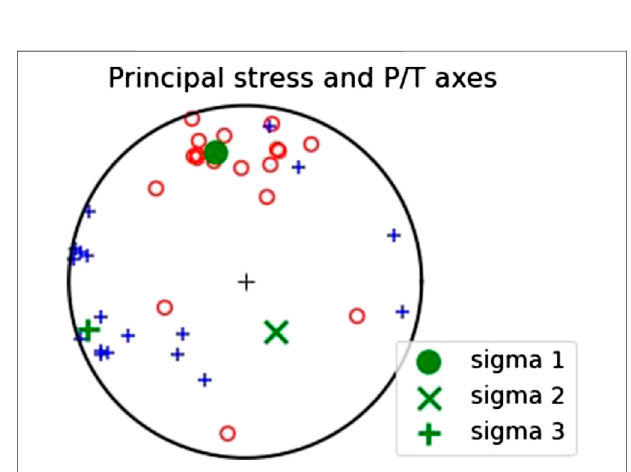
FIGURE 6 | P/T axes of Pidie Jaya aftershock focal mechanisms.